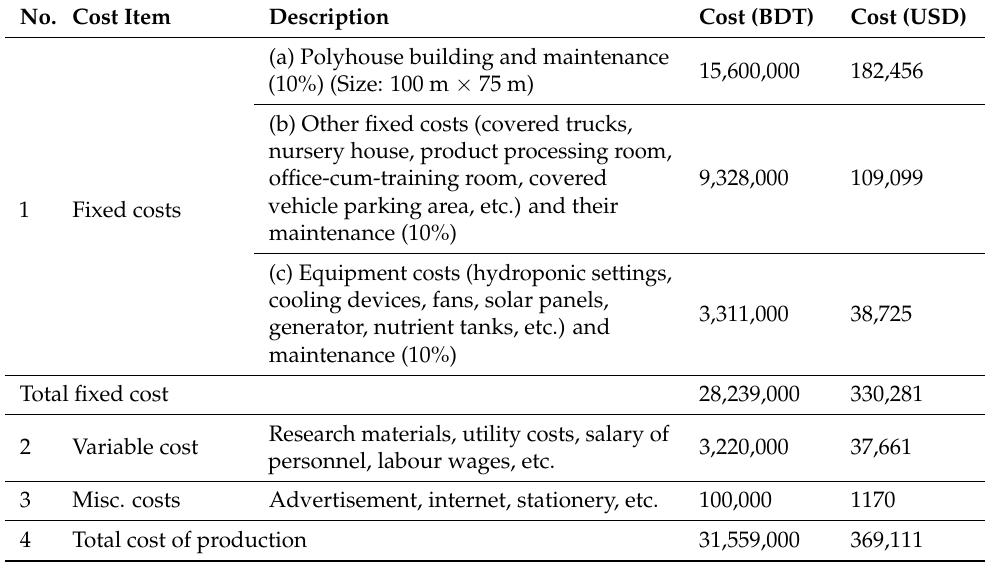
Table 1. Estimation of the cost of production of the selected vegetables.